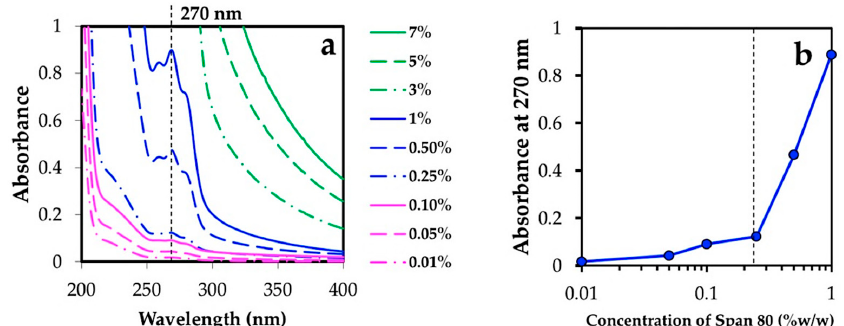
Figure 1. UV-Visible absorbance versus concentration profile of Span 80 in n-hexane at 20 ± 5 °C ( a ), and absorbance at 270 nm of Span 80 at various concentrations ( b ). Span 80 was dissolved in n-hexane at a concentration of 0.01–7% w/w. After thorough mixing, the solution was transferred to a 1.0 cm quartz cell and the spectrum was recorded at wavelengths of 200–400 nm using UV-visible near-infrared spectrophotometer (Jasco V570, Jasco Corporation, Tokyo, Japan). Blank n-hexane was used as a reference. The vertical dashed line in ( b ) marks the critical micelle concentration.